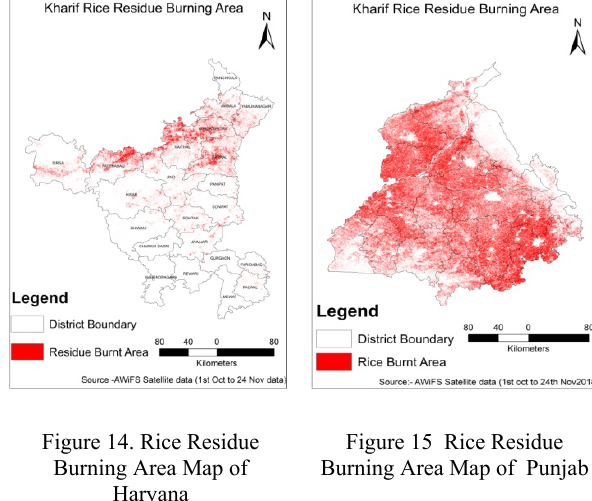
Figure 14. Rice Residue Burning Area Map of Haryana